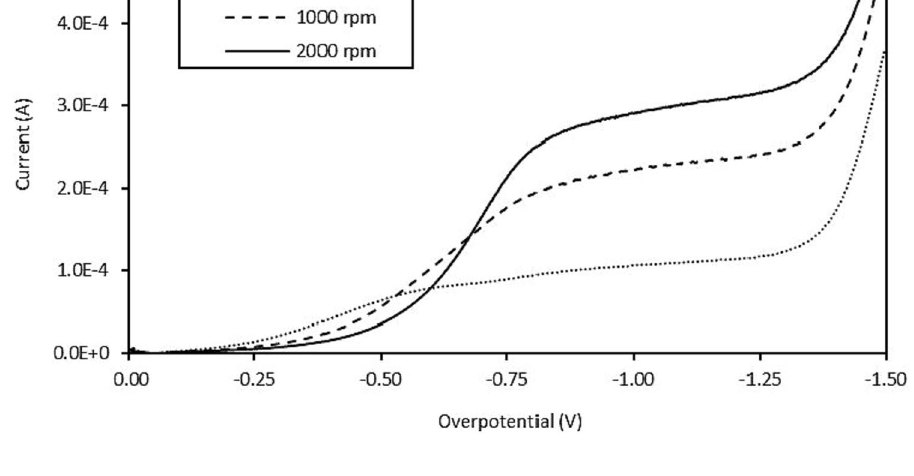
Fig. 10 IV curve for electrode of